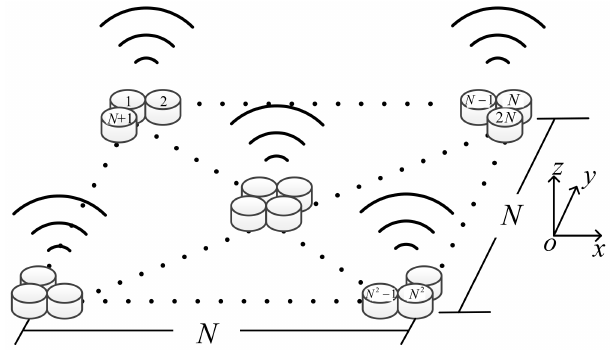
Figure 1. N × N ultrasound transducer